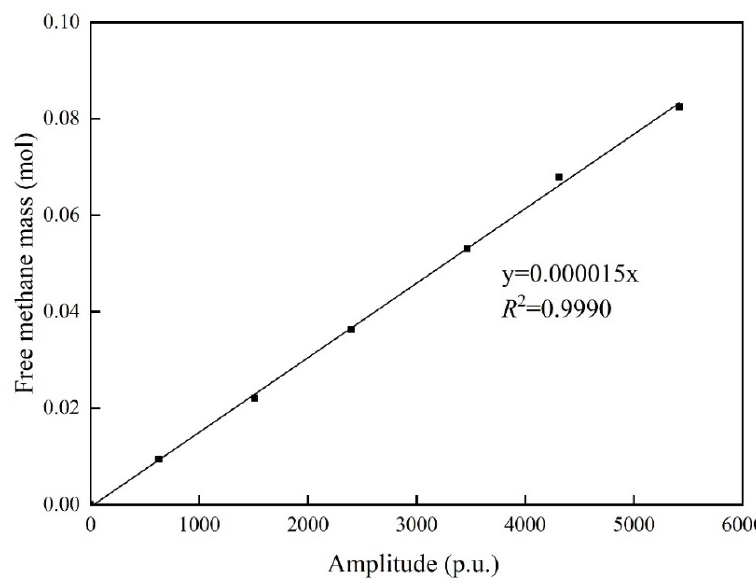
Figure 4. Correlations between T 2 amplitude vs. methane mass.